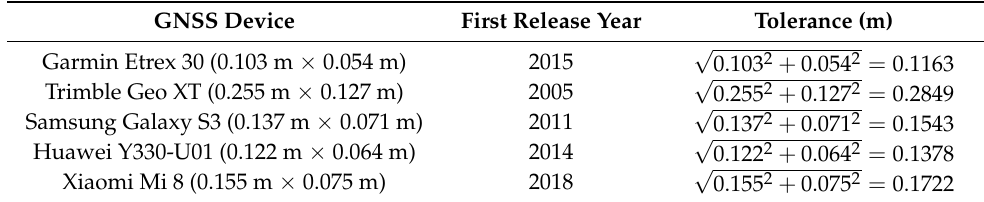
Table 1. The handheld global navigation satellite systems (GNSS) and smartphones used in the empirical tests. The tolerance of each GNSS device. The tolerance value will be the quadratic composition of the devices’